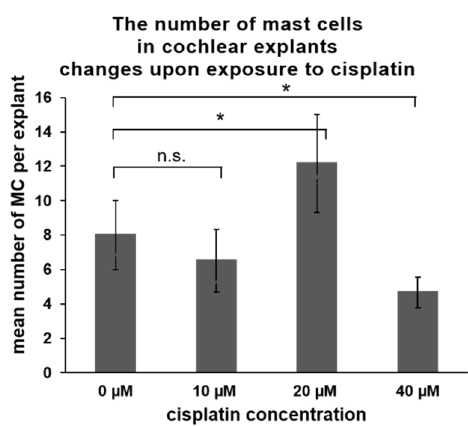
Figure 6. Cisplatin exposure-induced changes in a number of cochlear MCs of Wistar rats (p5). The explants ( n = 6 per treatment) were exposed to various concentrations of cisplatin. The numbers of cochlear MCs were scored and are presented as an average value (whiskers +/ − SD). A significant increase in the MC number was observed when 20 µ M cisplatin was used, whereas a decrease was observed when 40 µ M cisplatin was used. Significance: * p < 0.05, Student’s-t test; n.s.—not significant.